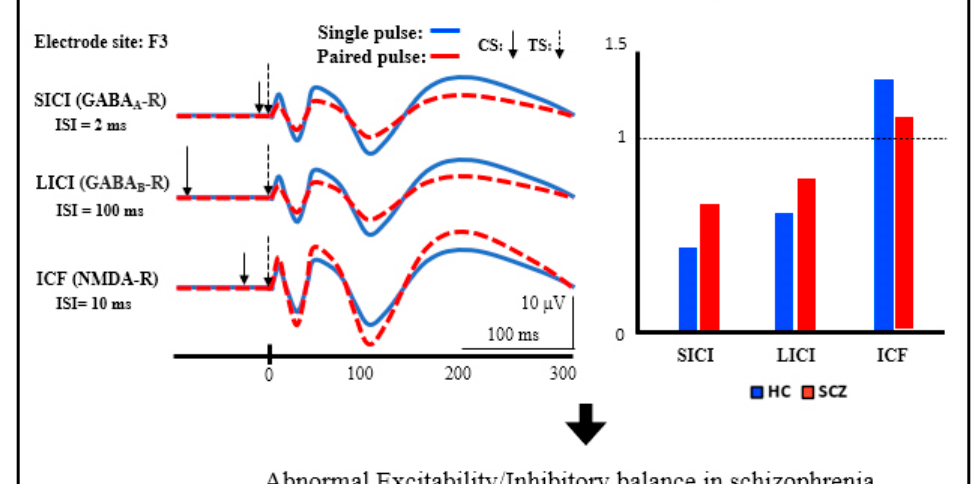
Figure 2. Schematics of combined TMS-EEG neurophysiology from the